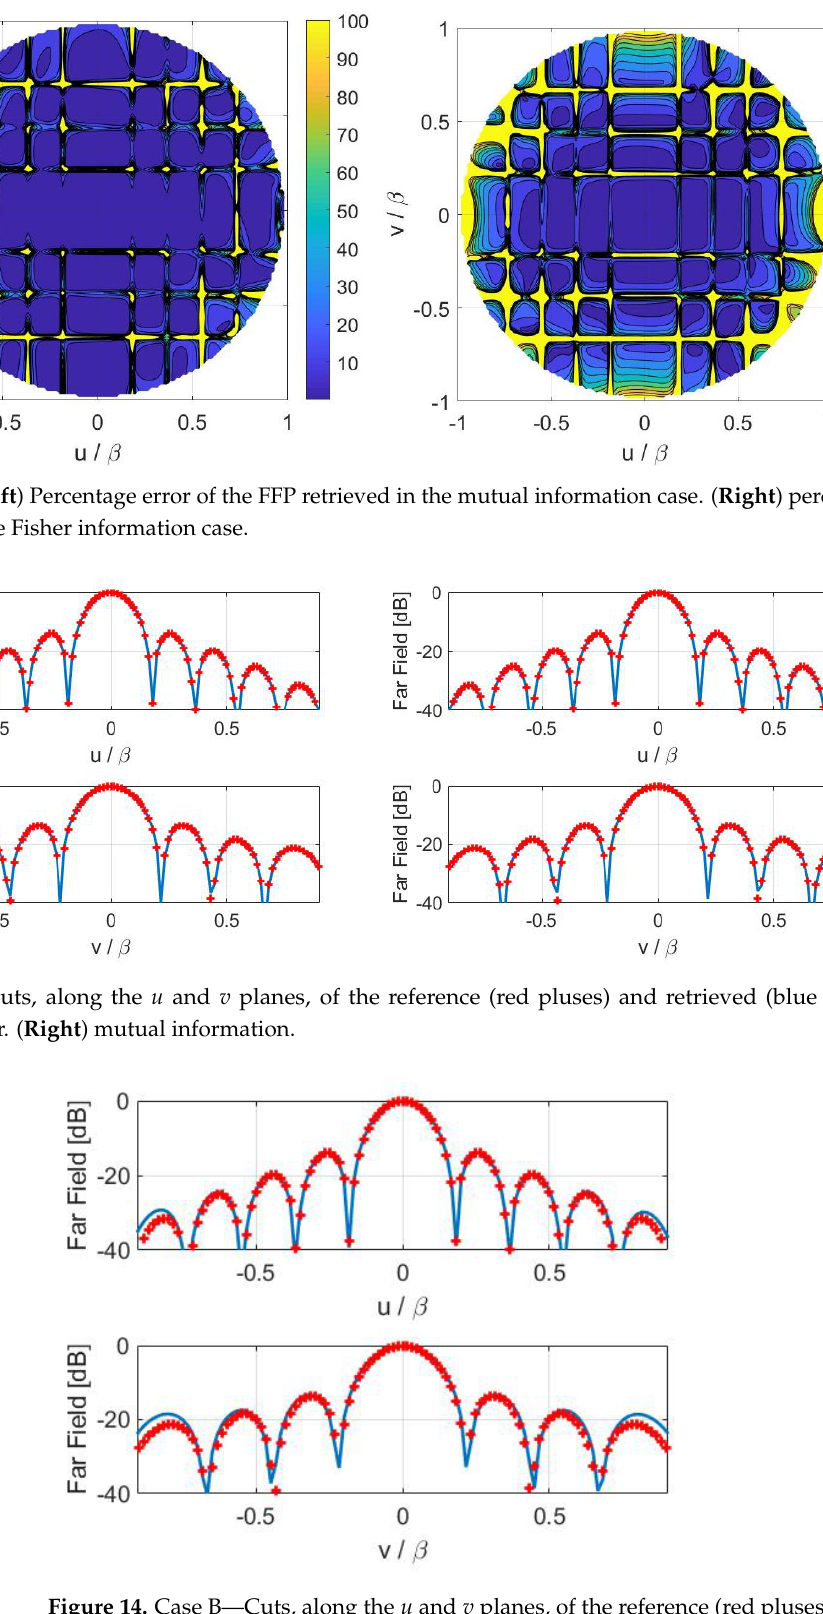
Figure 14. Case B—Cuts, along the u and v planes, of the reference (red pluses) and retrieved (blue solid line) FFP. Fisher